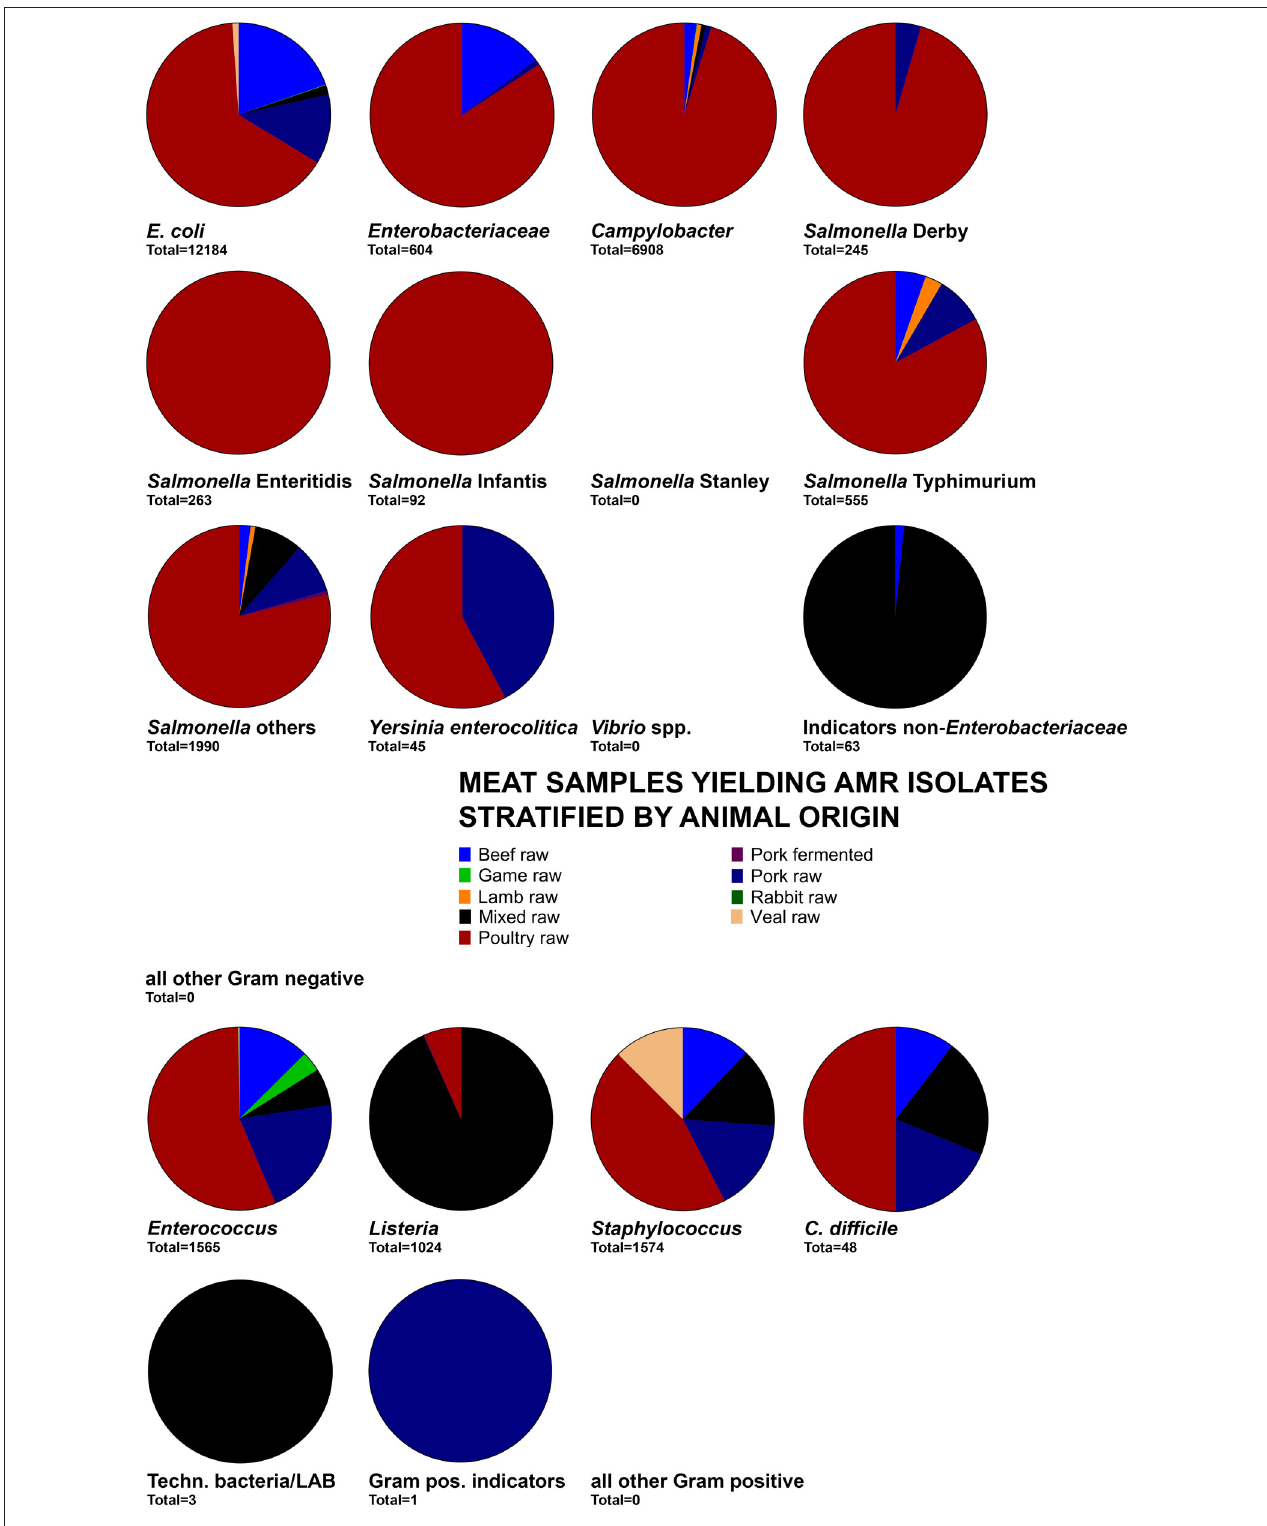
FIGURE 3 | Distribution of the number of meat samples yielding AMR isolates by food categories. The total below each pie chart indicates the total of samples used to calculate the graph.